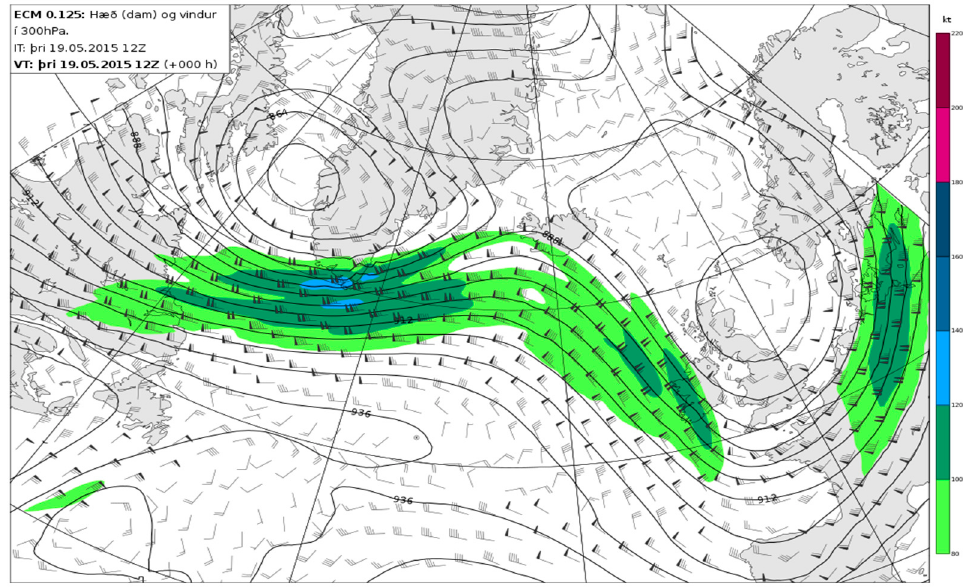
Figure 23. ECMWF 0-hr analysis for upper winds (300 hPa/~9.1 km) on 12Z 19 May 2015. (Data processed by the Icelandic Meteorological Office).